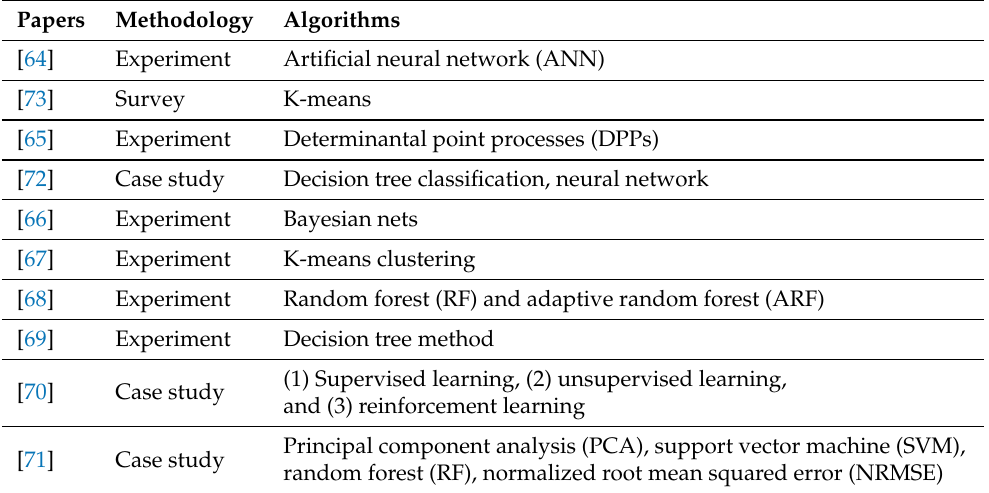
Table 5. Algorithms and approaches used for adaptive and predictive learning and learning